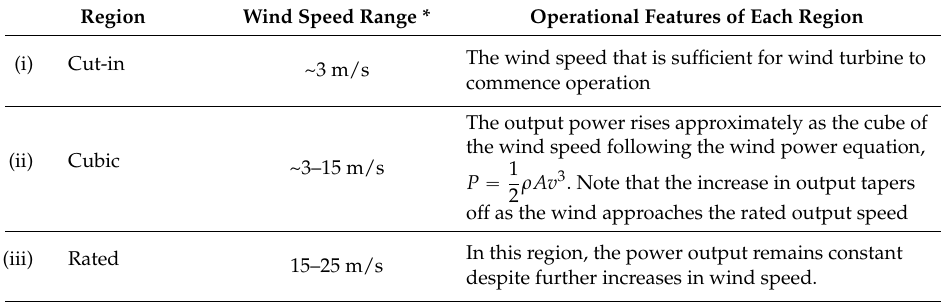
Table 1. The different wind speed ranges of the power curve that relate to the regions in Figure 1. Region Wind Speed Range * Operational Features of Each